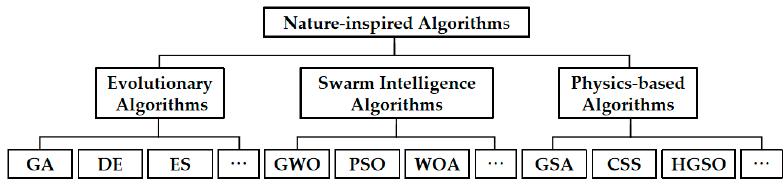
Figure 1. Classification of nature-inspired optimization algorithms .